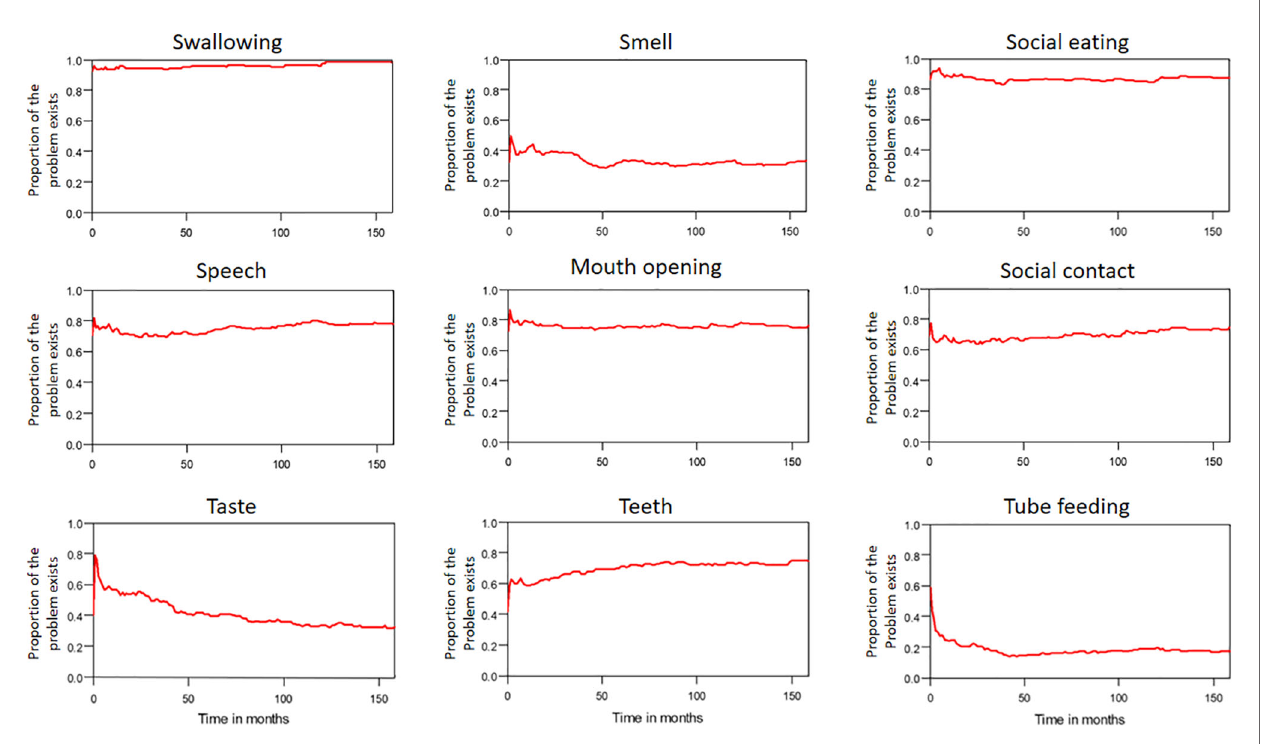
FIGURE 8 | The trends of different problems in patients with OSCC.